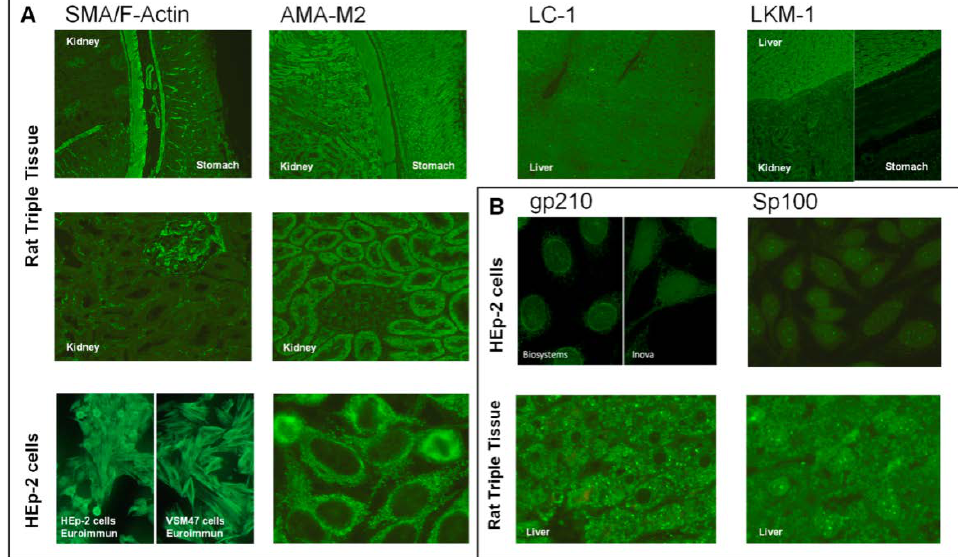
Figure 1. Indirect immunofluorescence patterns on rat triple tissue or HEp-2 cells of the main autoantibodies in AIH and PBC. Main anti-cytoplasmic ( A ) and anti-nuclear ( B ) patterns associated with AIH and PBC are shown. Abbreviations: AMA, anti-mitochondrial autoantibodies; gp210, glycoprotein 210; LC-1, liver cytosol-1; LKM-1, liver-kidney microsomal type-1; SMA, smooth muscle autoantibodies.